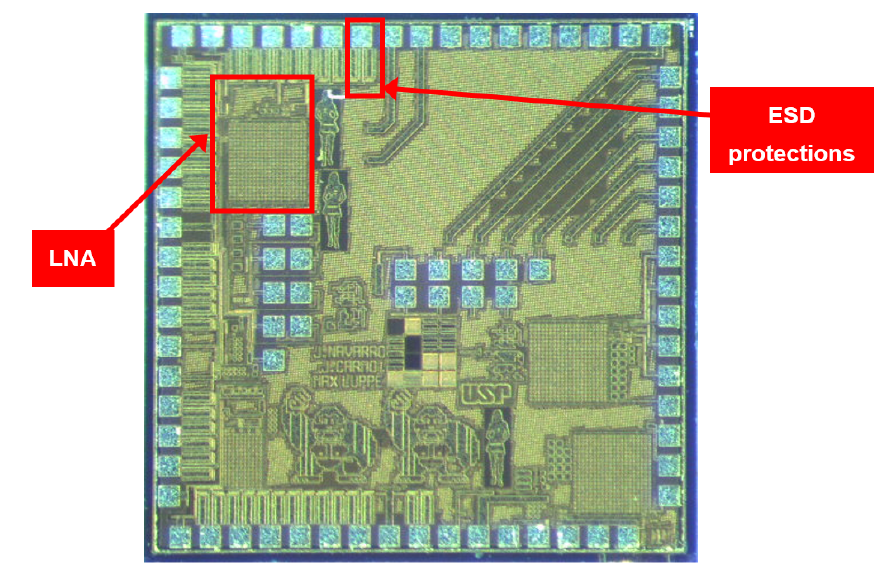
Figure 16. Photograph of the fabricated CMOS microdevice (1660 µ m × 1660 µ m), with emphasis on the LNA presented in this paper and on one of the ESD protections.